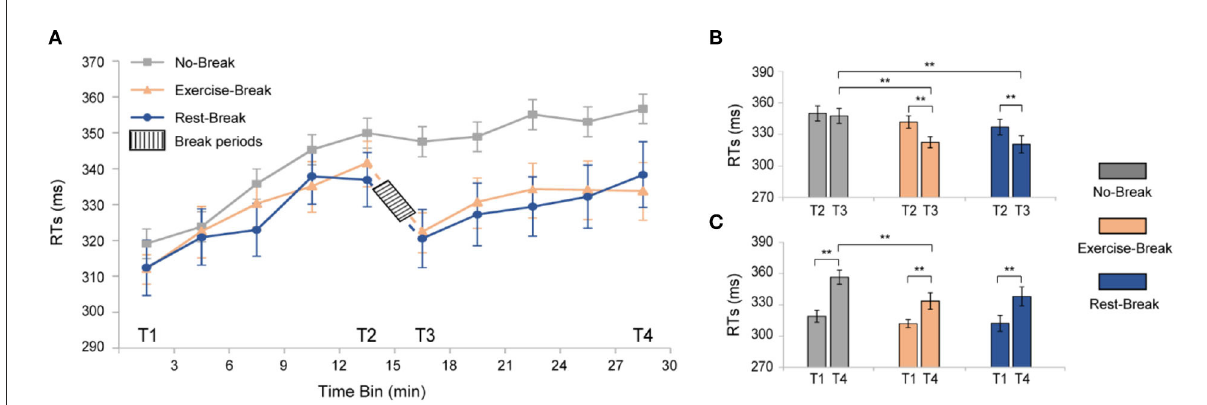
FIGURE3 Behavioral results for the three different sessions. (A) RTs of PVT task segmented into 3-min bin. (B) post-hoc analyses for the immediate effect of mid-task interventions. (C) Post-hoc analyses for the general effect of the mid-task breaks. ** p < 0.01. Error bars represent the mean ±